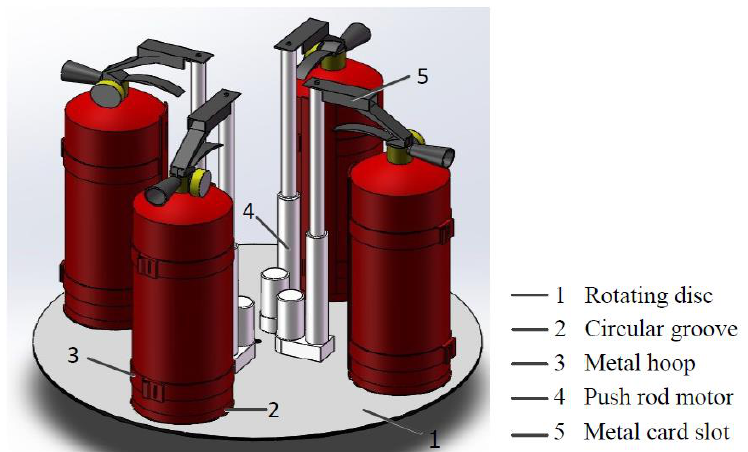
Figure 11. Fire-extinguishing system installed on the robot.